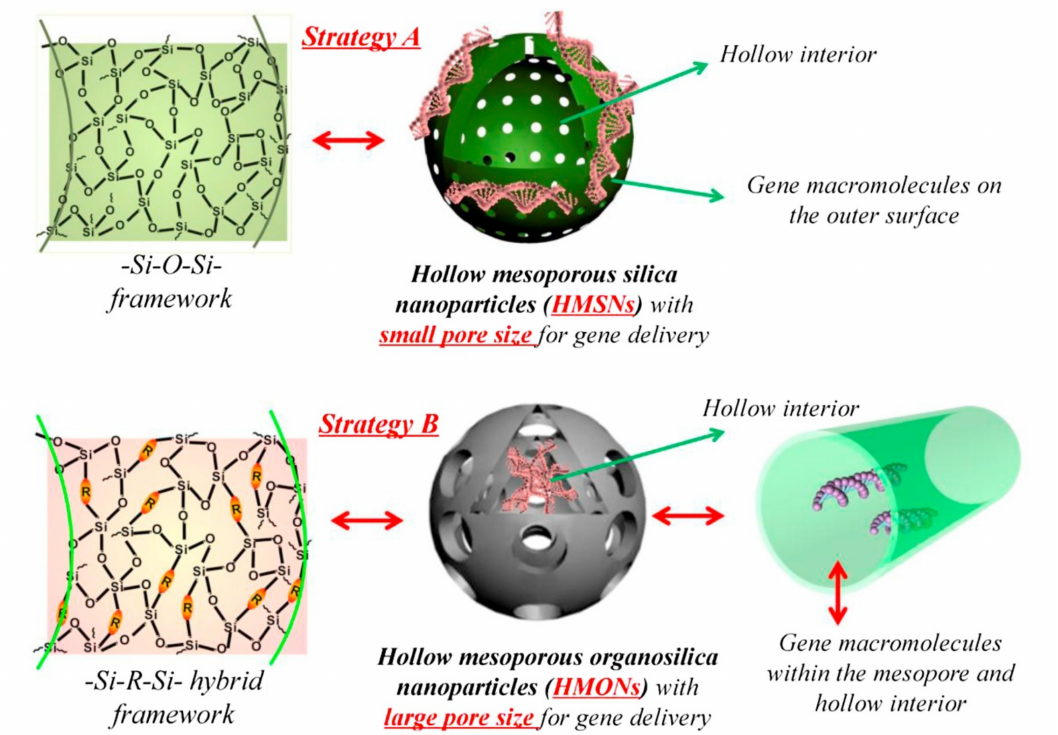
Figure 3. Schematic representation of the possible strategies for nucleic acid delivery using hollow MSNs: particles withsmall pore sizes canonly carry thenucleic acid ontheir surface (top), while particles with large pores can carry the nucleic acid cargo within them. This image is used without modifications from [74]. Copyright © 2016,